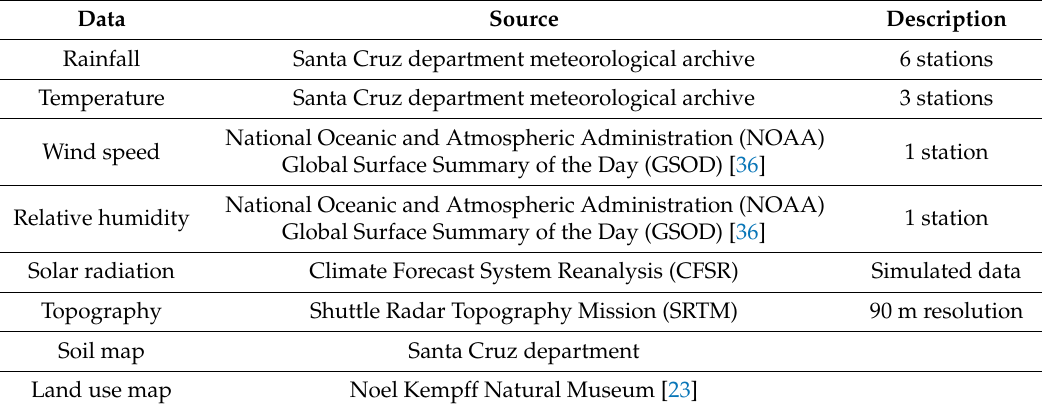
Table 1. Input data for Soil and Water Assessment Tool (SWAT) hydrological model